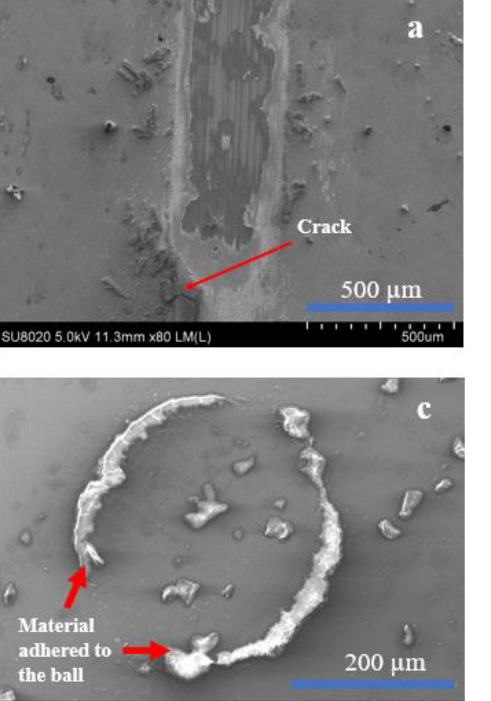
Figure 11. ( a , b ), SEM micrographs of the wear track of the heat-treated electroless nickel boron; ( c , d ), surface of alumina balls after the dry ball-on-flat sliding test.